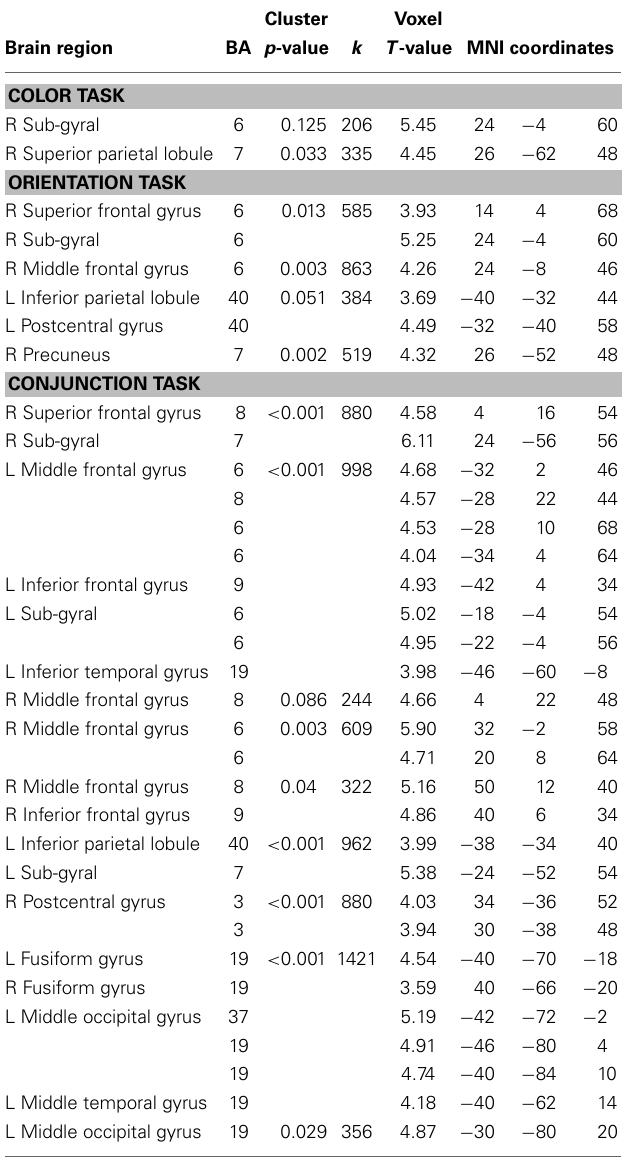
Table 1 | MNI coordinates of brain regions that were significantly activated by the binding condition (vs. control condition).